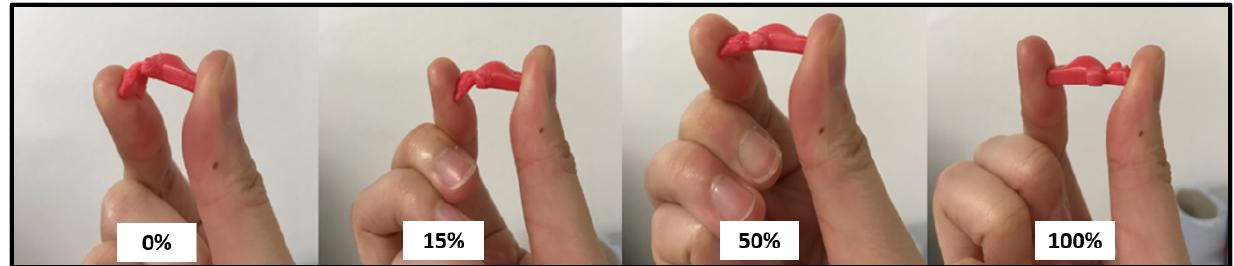
Figure 4. Design 4 (i.e., gummy bear shape) remotely 3D ‐ printed at 0%, 15%, 50%, and 100% infill flexibility). Table 5. Different infill densities of 3D ‐ printed gummy bear shape tablets (design 4). Data for diam ‐ Table 3. Physical properties of remotely-3D-printed model designs 1 to 3. Data for diameter, length, eter, length, and thickness represent the mean ± standard deviation (SD), where n = 2. and thickness represent the mean ± standard